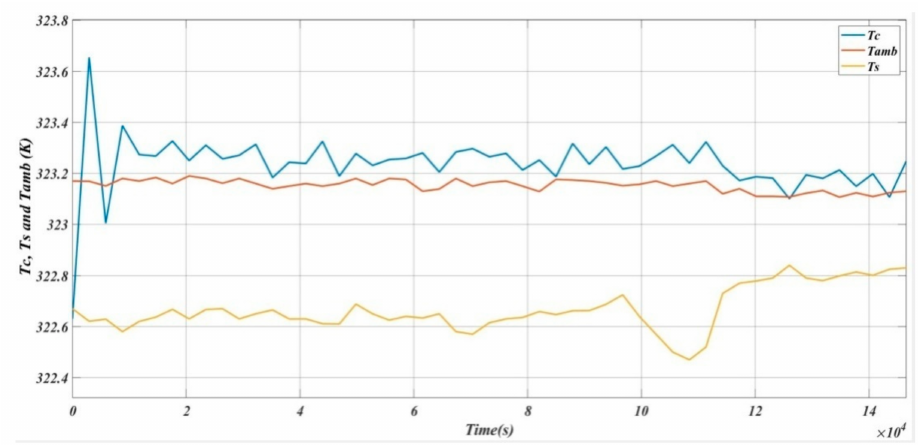
Figure 7. The plot of T c , T s and T amb without using KF.